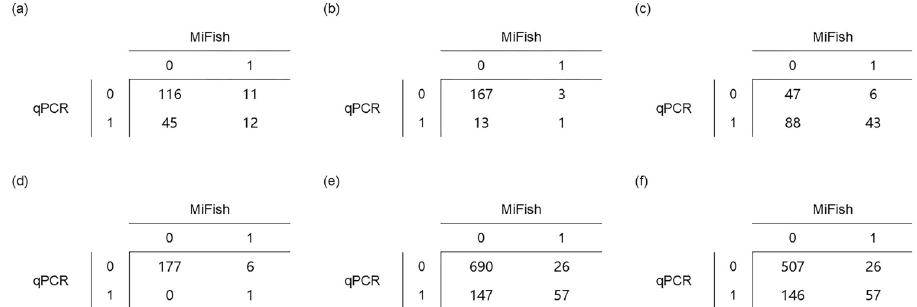
Fig 4. Comparison tables for Phi-coefficients analysis of detection performance among the five target fish. (a) chub/blue mackerel ( Scomber japonicus and Sc . australasicus ), (b) anchovy ( Engraulis japonicus ), (c) sardine ( Sardinops melanostictus ), (d) saury ( Cololabis saira ), (e) pooling (sum data of all five target fish, chub/blue mackerel, sardine, anchovy, saury and jack mackerel), (f) pooling-4 (sum data of (a) to (d)). 0 = absence, 1 = presence.